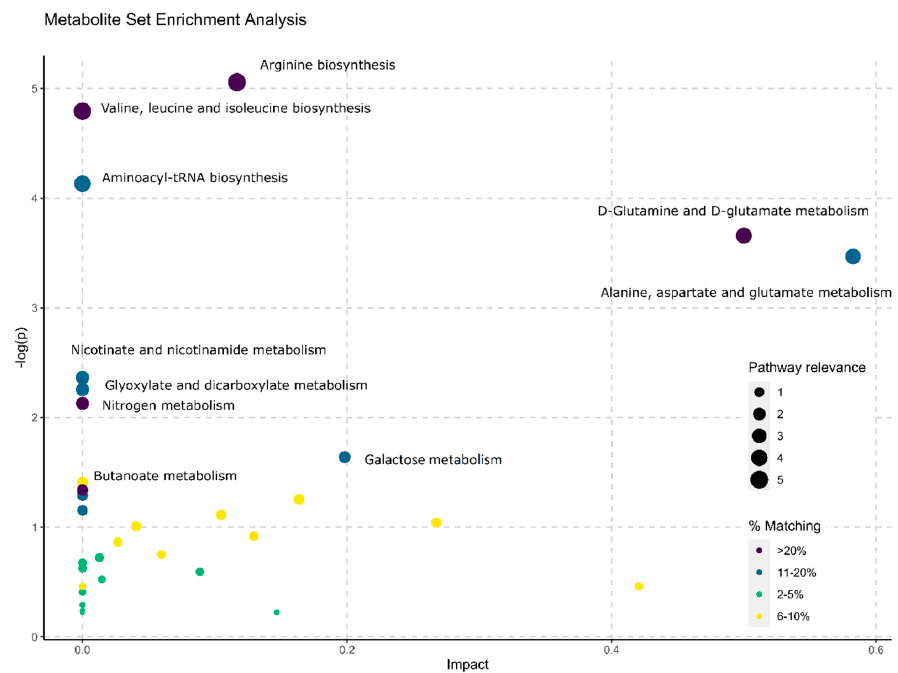
Figure 4. Metabolite set enrichment analysis establishes whether compounds implicated in a